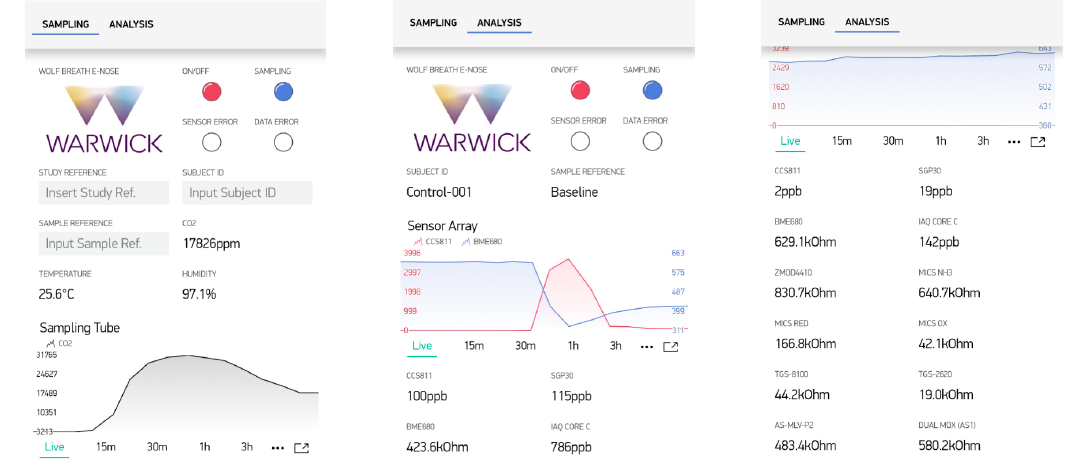
Figure 5. WOLF Breath E-nose Blynk app; ( left ) Sampling tab; ( middle ) Analysis tab with real-time Figure 3. WOLF Breath E-nose Blynk app; (left) Sampling tab; (middle) Analysis tab with real-time 167 output graph; ( right ) Analysis tab with all sensor output graph; (right) Analysis tab with all sensor readings. 168